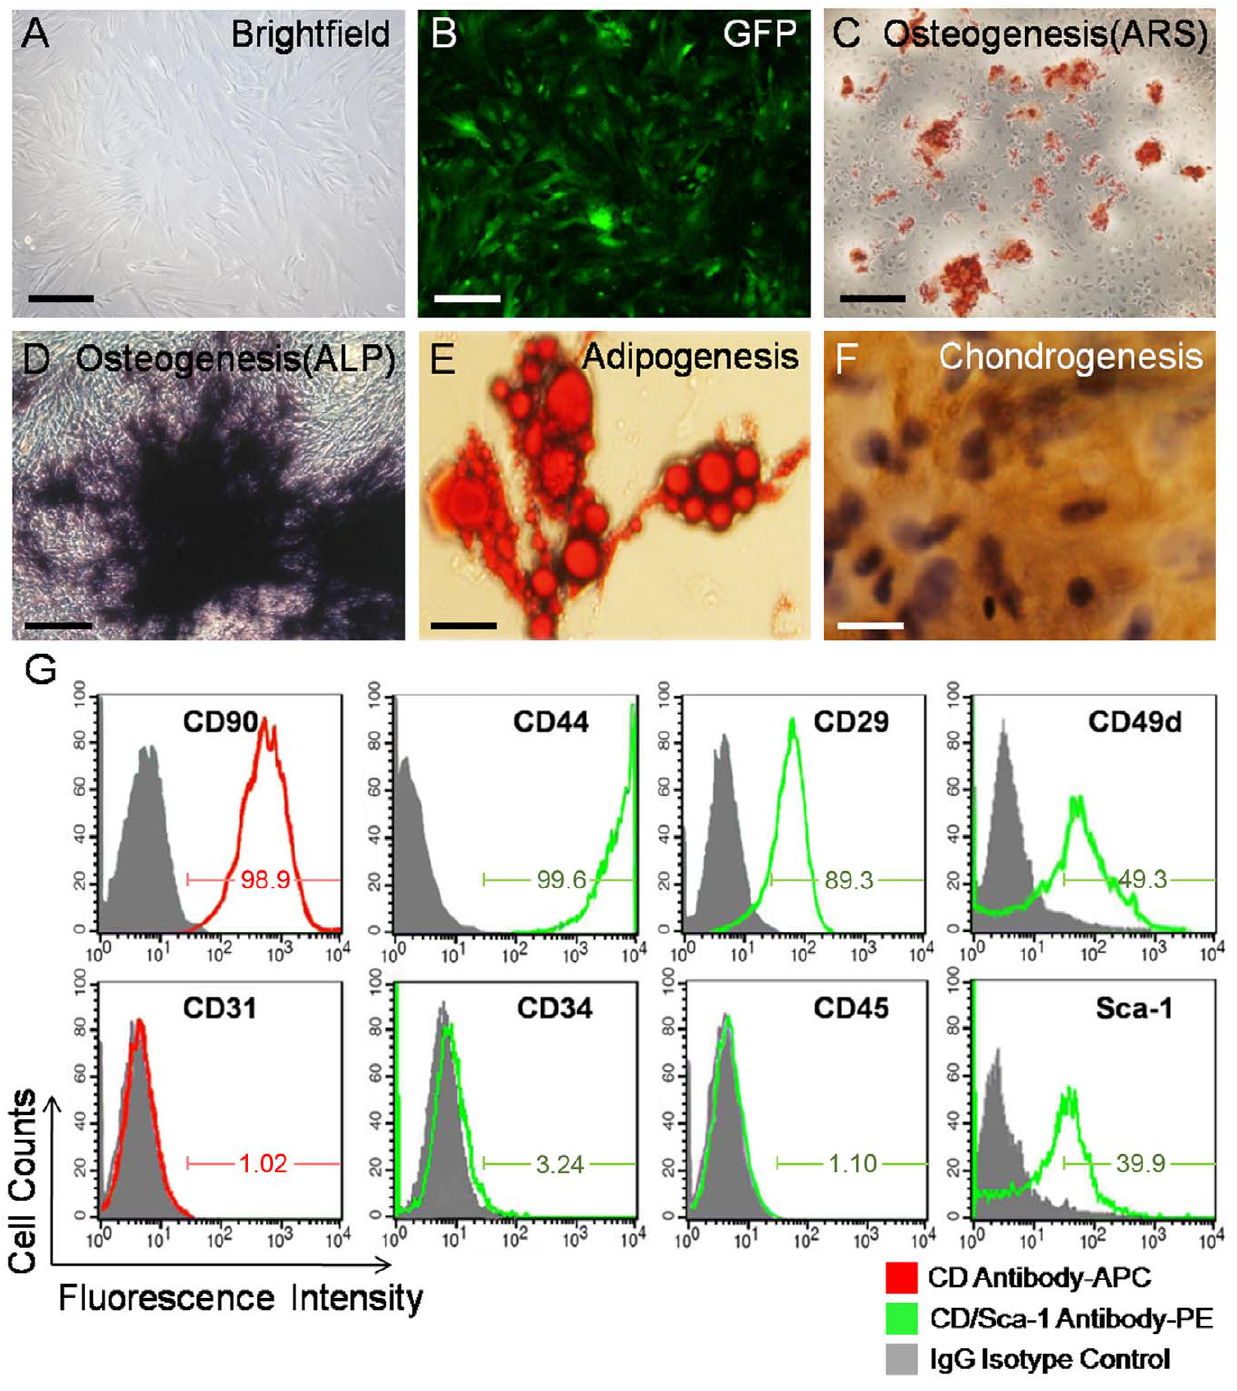
Figure 1. mADSCs Fluc + GFP + characterization. Fibroblastoid morphology ( a ) and enhanced green fluorescent protein (eGFP) expression ( b ) of Fluc + 2 GFP + murine adipose-derived stromal cells (mADSCs Fluc + GFP + , 3 rd passage). Multipotent differentiation of mADSC Fluc + GFP + is shown in c–f . Osteogenesis was demonstrated using alizarin red-S (ARS, c ) or alkaline phosphatase (ALP, d ) staining. Adipogenesis and chondrogenesis were detected using oil red-O staining ( e ) and collagen-II immunohistochemistry staining ( f ) respectively. Flow cytometry of mADSCs labeled with phycoerythrin(PE)/allophycocyanin(APC)-conjugated cell markers or isotype IgG controls for immunophenotype identification ( g ). Scale bar represents 100 m m (a,b,c,d), 15 m m (e,f). identification of transplanted mADSCs Fluc + GFP + in detailed 3D structed total power of bioluminescence signal displayed better anatomic resolution ( Figure 3d and Movie S1, S2, S3, S4 ). linear correlation with the living cells number than 2D BLI signal Furthermore, we have previously demonstrated that 3D -recon- intensity in vivo [12]. BLT/micro-CT also detected the decreased